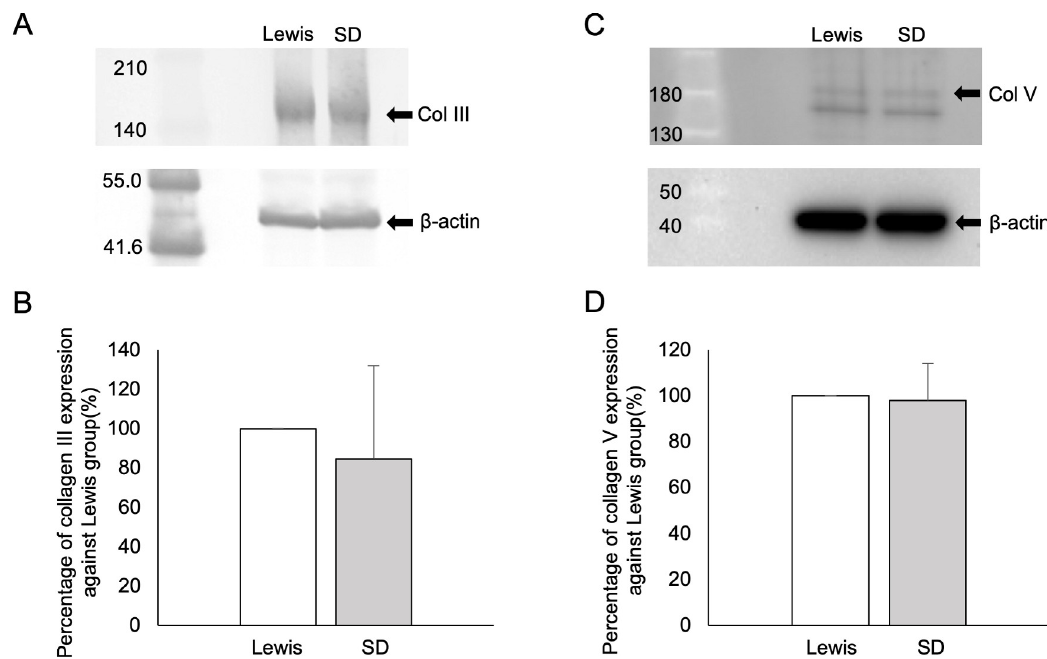
Fig 5. Western blot analyses of Col III (A, B) and Col V (C, D) in the pancreatic tissues of each rat strain. The findings for SD rats are presented as the percentage when those of Lewis rats were considered 100% (B, D). β -actin was used as a control (A, C).